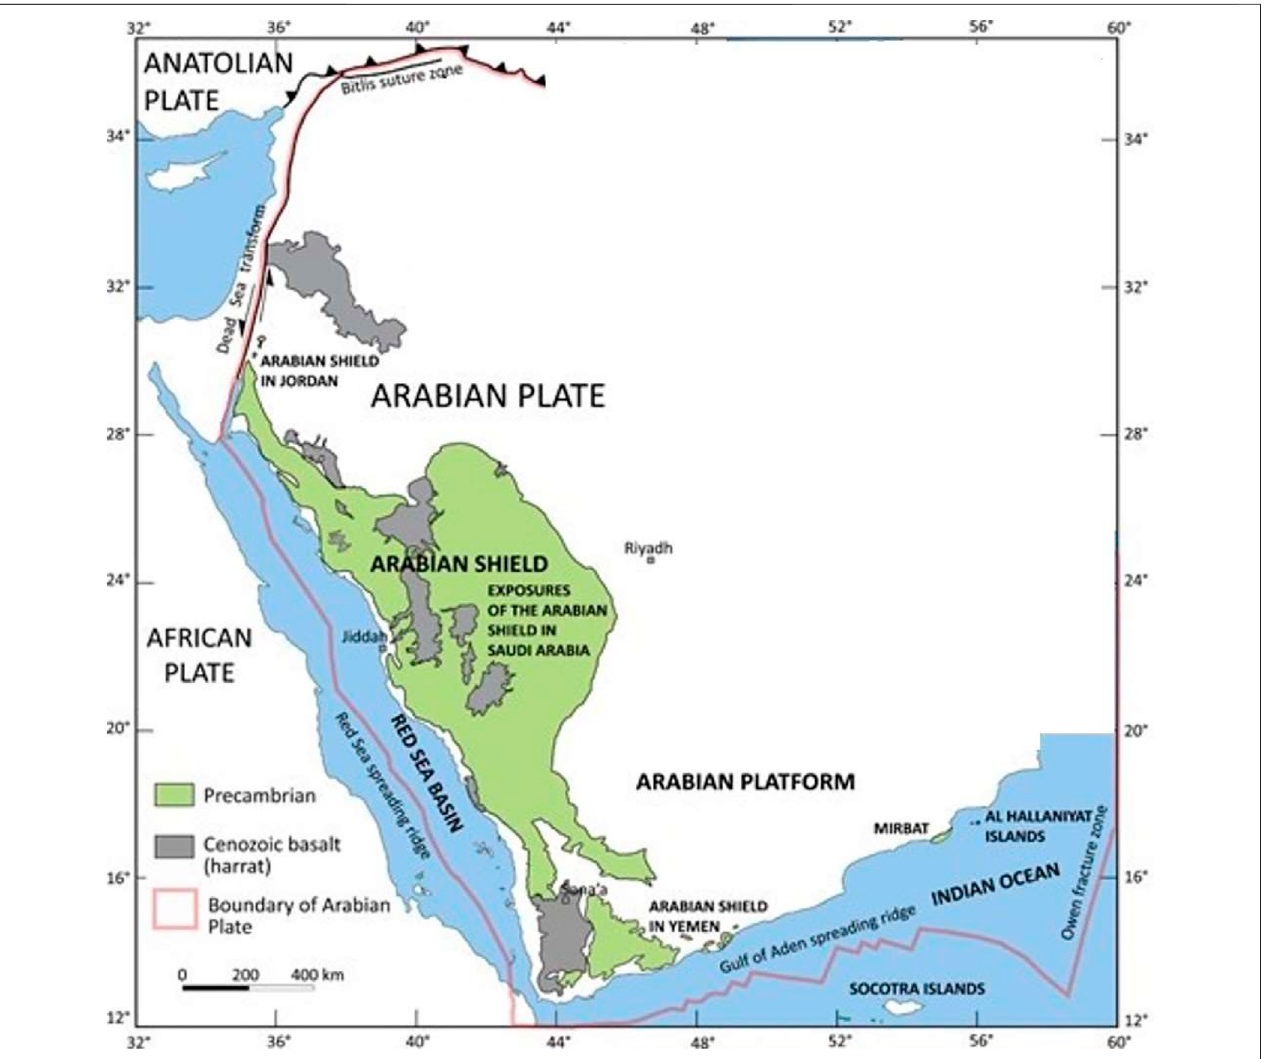
FIGURE1| TheArabianPlate,showingoutcropsofNeoproterozoicandolderrocksintheArabianShieldandOman,Cenozoicbasaltassociatedwiththeopening of the Red Sea, and the plate boundaries — extensional in the south and west, convergent in the north and northeast, and transcurrent in the northwest and southeast (https://sgs.org.sa/en/ topics/landforms-of-saudi-arabia/).